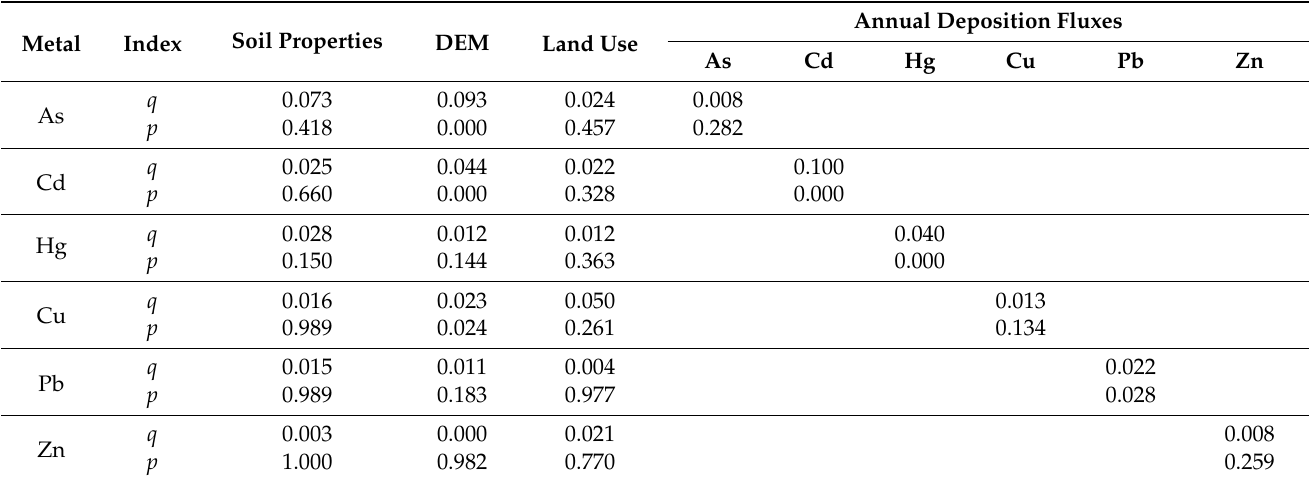
Table 2. The influencing factors on heavy metal concentrations at the single-object